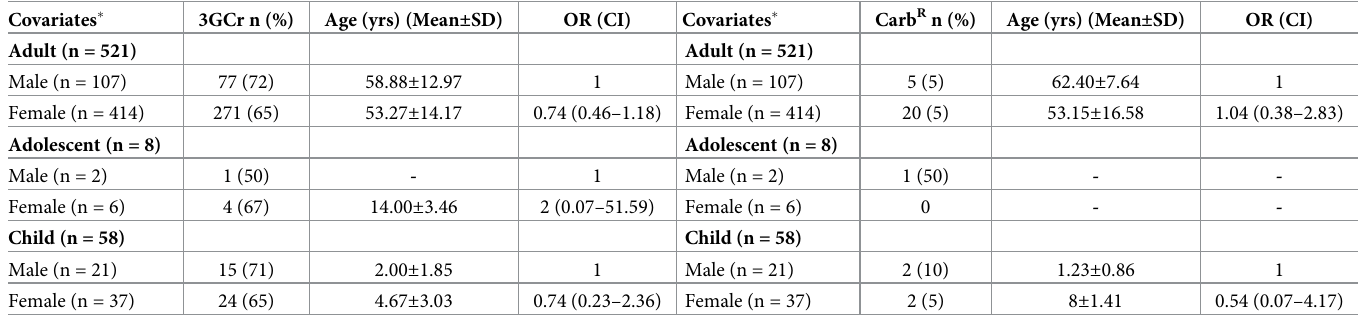
Carb R , carbapenem resistant; n, number; 3GCr, 3 rd generation cephalosporin resistant � One isolate represents one patient. A total of 587 Gram-negative isolates were tested for susceptibility against third-generation cephalosporin and carbapenem